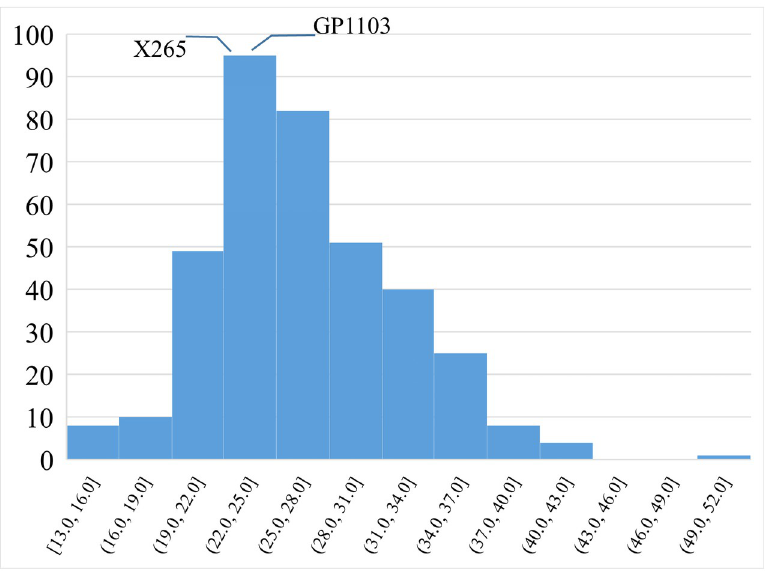
Fig 6. Histogram showing the frequency distribution for total panicle weight among 340 lines of the X265 x GP1103, F5 population. Plants were evaluated under low input condition in the central highland of Madagascar. The mean of GP1103 and X265 are shown in